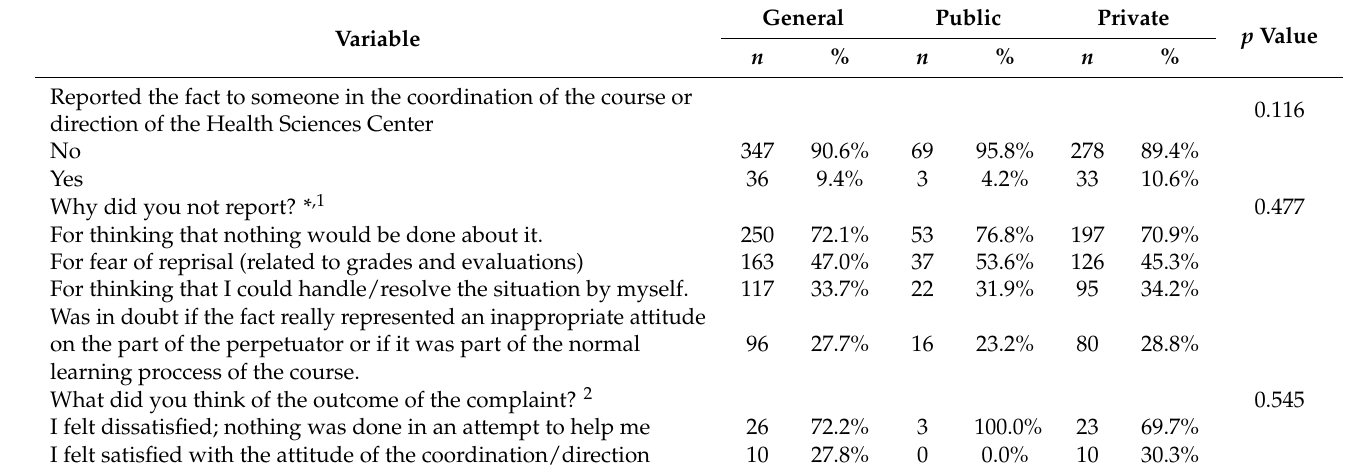
Table 4. Frequency distribution of data related to reporting episodes, by institution.